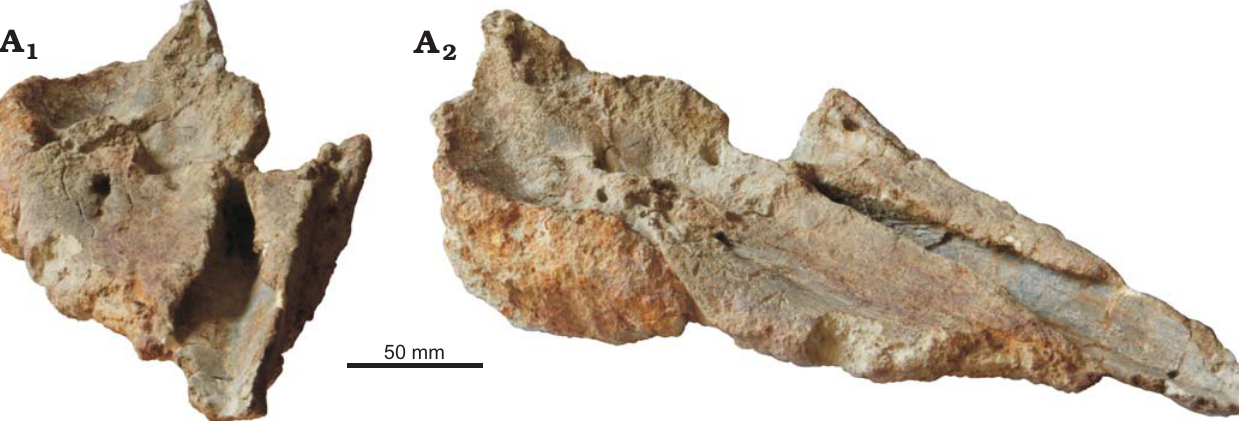
Fig. 5. Cranium of the kogiid sperm whale Pliokogia apenninica gen. et sp. nov. (MSNUP I-17603, holotype), from the lower Pliocene of Sant’Andrea Bagni (Northern Apennines, northern Italy); in anterodorsal (A 1 ) and right anterodorsolateral (A 2 )